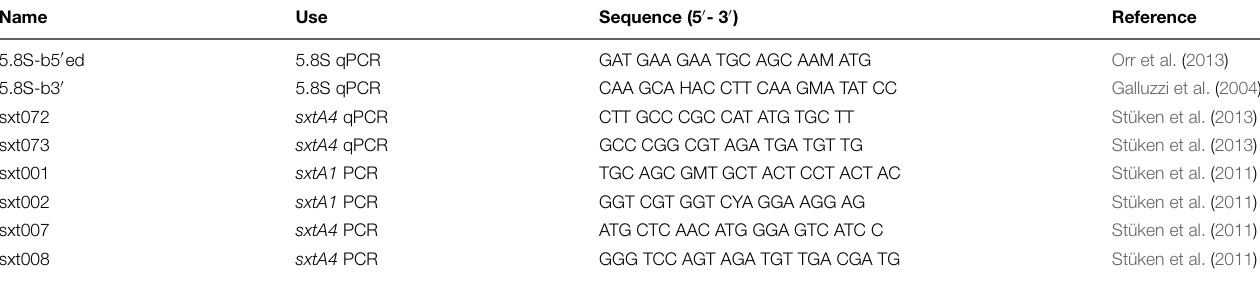
TABLE 2 | Primers used in this